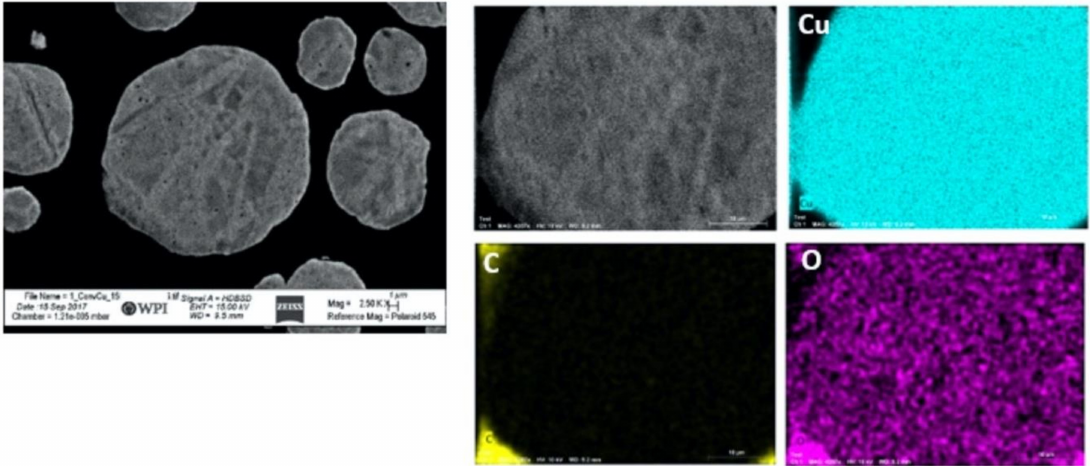
Figure 6. EDS analysis of GA Cu powder. O and Cu are of interest, whereas the C content follows from the chemical nature of the mounting material.